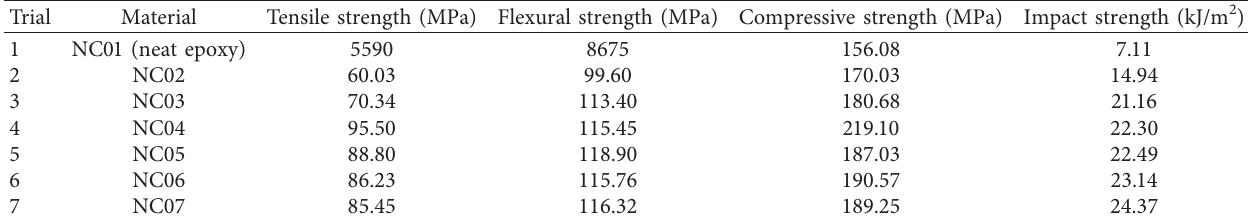
Table 5: Effects of epoxidized linseed oil to the mechanical strength of blend materials. Trial